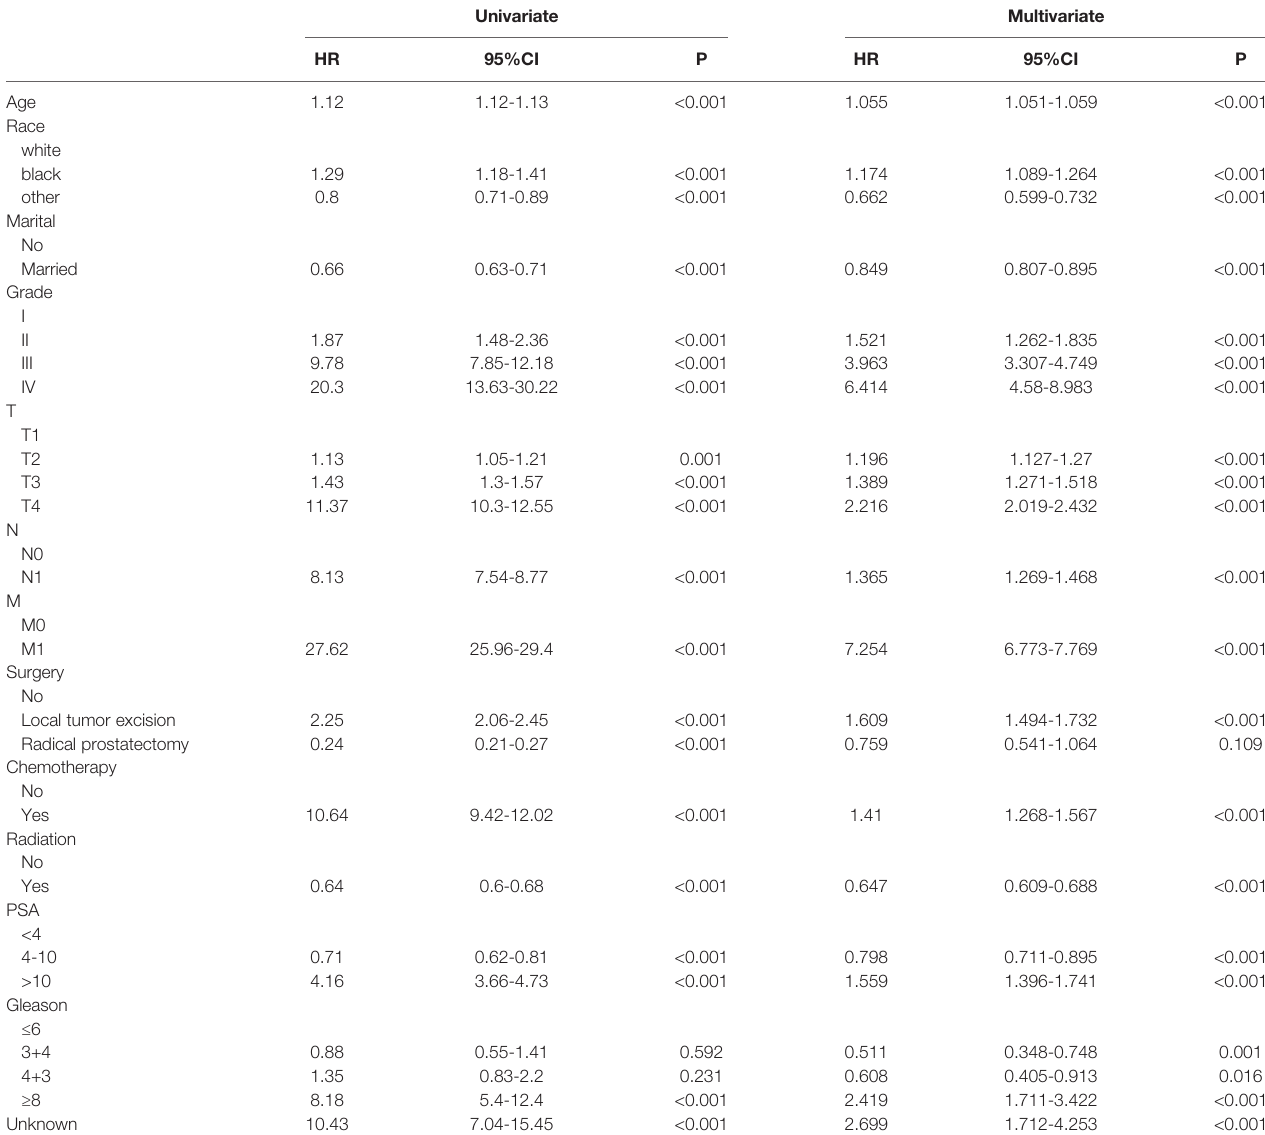
TABLE 2 | Univariate and multivariate analyses of CSS in training